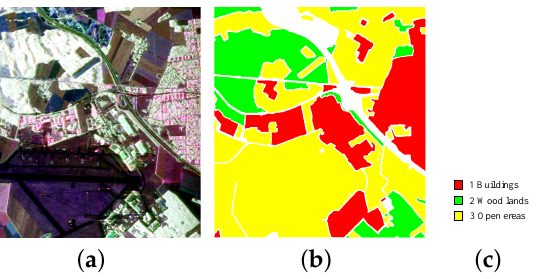
Figure 6. ( a ) The Pauli color-code image of Oberpfaffenhofen data set. ( b ) The corresponding ground truth. ( c ) The legend of the ground